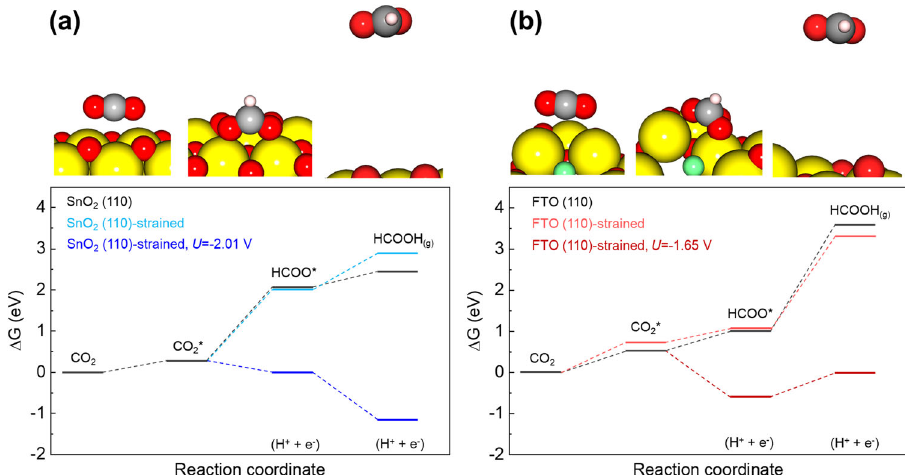
Fig. 3 DFT calculation results of Sn-based catalysts for electrochemical CO 2 conversion to formate. Free energy diagram of CO 2 to HCOOH conversion reaction on the a SnO 2 (110) and b FTO (110) surface (yellow: Sn, red: O, white: H, green: F). The strained supercells were used to simulate the structural change on SnO 2 and FTO nanoparticles at an applied potential of 1.0 V under CO 2